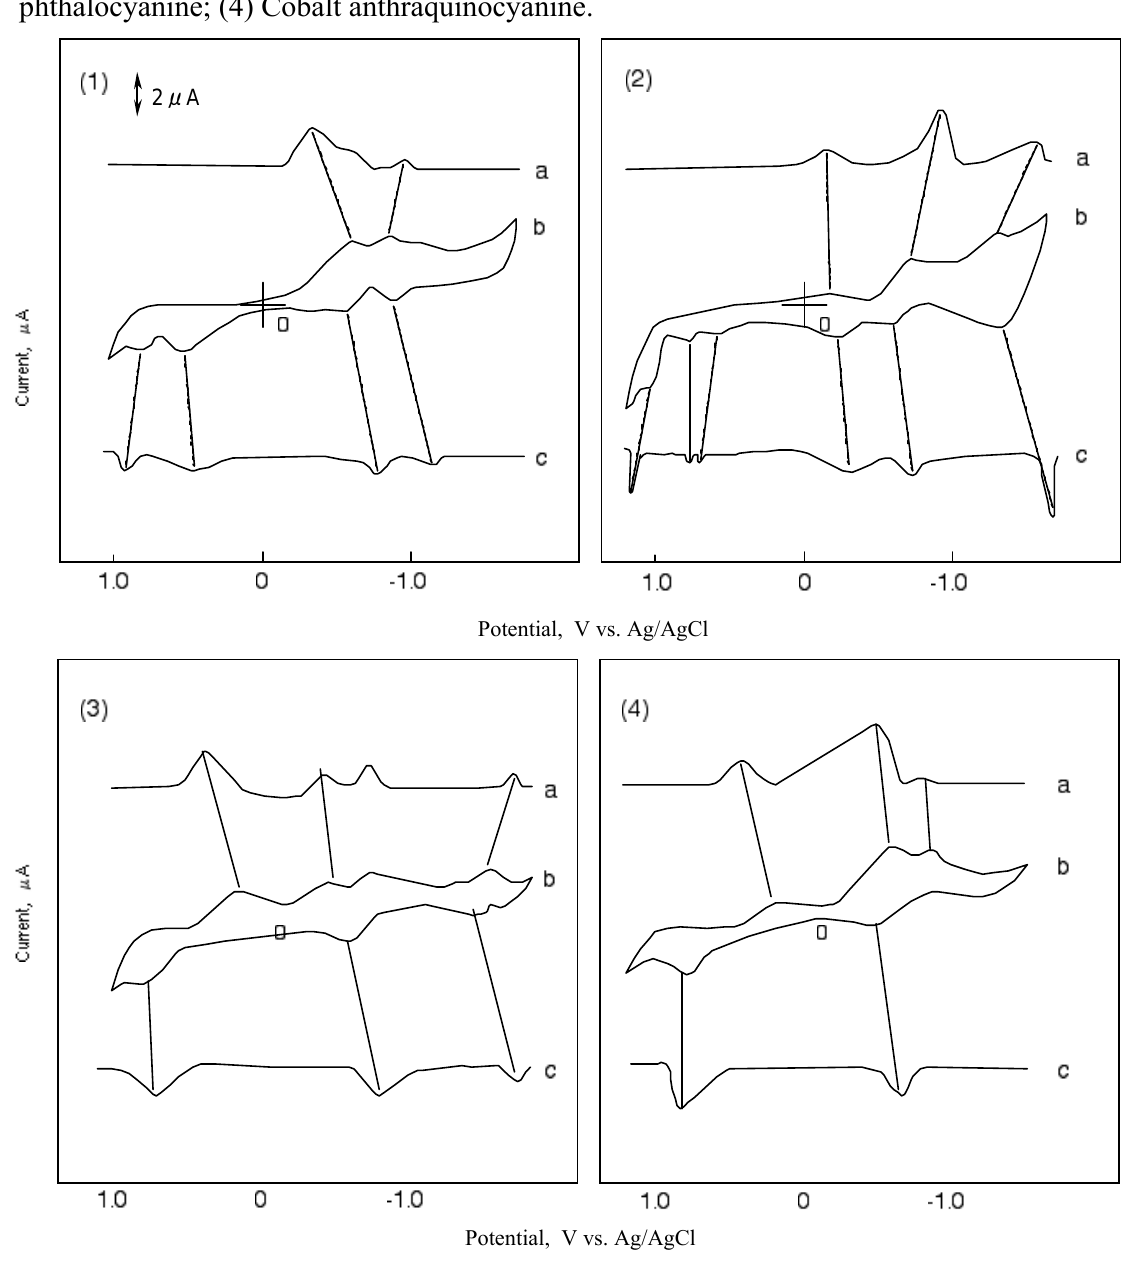
Figure 5. Cyclic voltammograms and their first differential curves of covalt phthalocyanine derivatives in dimethylsulfoxide (DMSO) with 0.1 mol·L -1 tetrabutylammonium perchlorate (TBAP), scan rate: 50 mV·s -1 ; a): First differential curve of upper half of cyclic voltammogram; b): Cyclic voltammogram; c): First differential curve of lower half of cyclic voltammmogram; (1) Cobalt phthalocyanine tetrasulfonic acid; (2) Cobalt phthalocyanine octacarboxylic acid; (3) Cobalt octakis(hexoxymethyl)- phthalocyanine; (4) Cobalt anthraquinocyanine. 2 μ